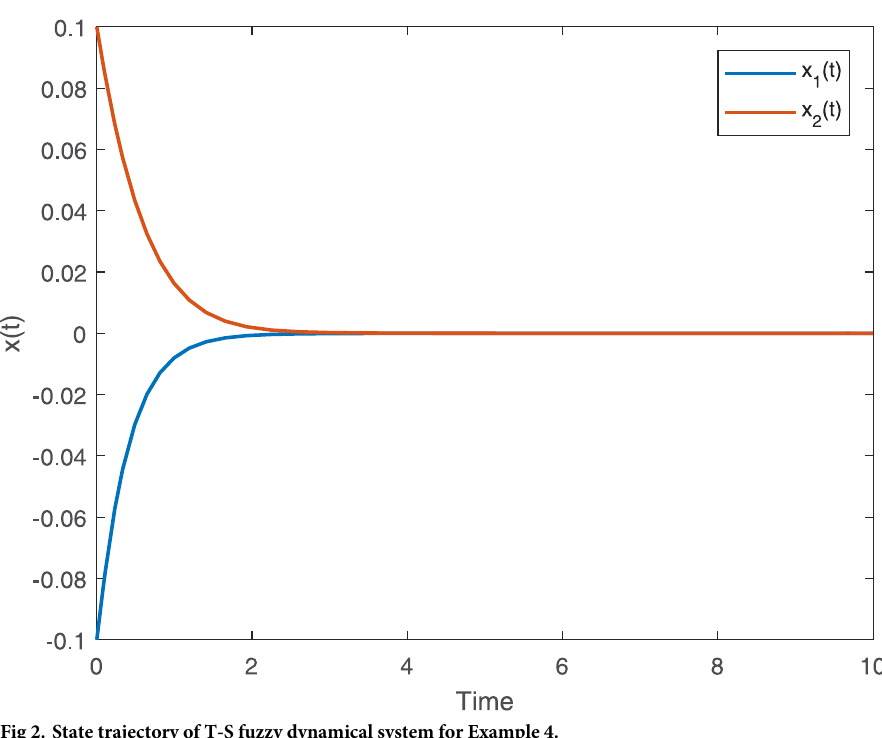
Fig 2. State trajectory of T-S fuzzy dynamical system for Example 4.